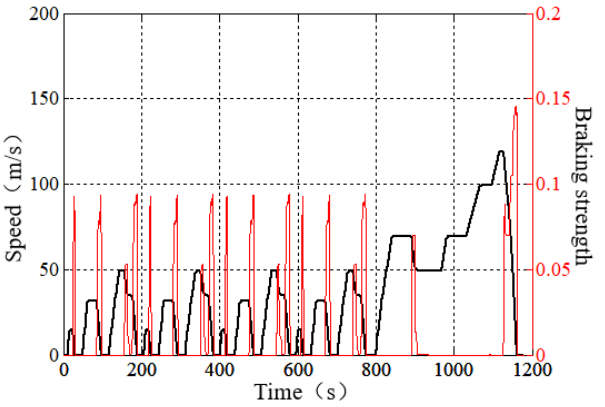
Figure 11. Working condition of